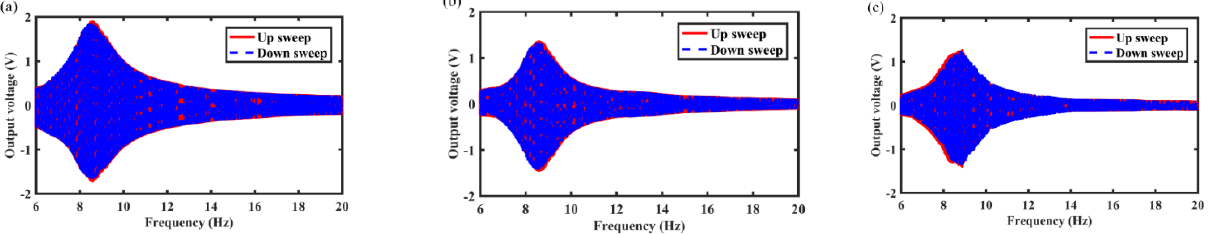
Figure 6. Frequency sweep response of the MCEEH with excitation acceleration of 0.5 g: ( a ) coil 1; ( b ) coil 2; ( c ) coil 3.